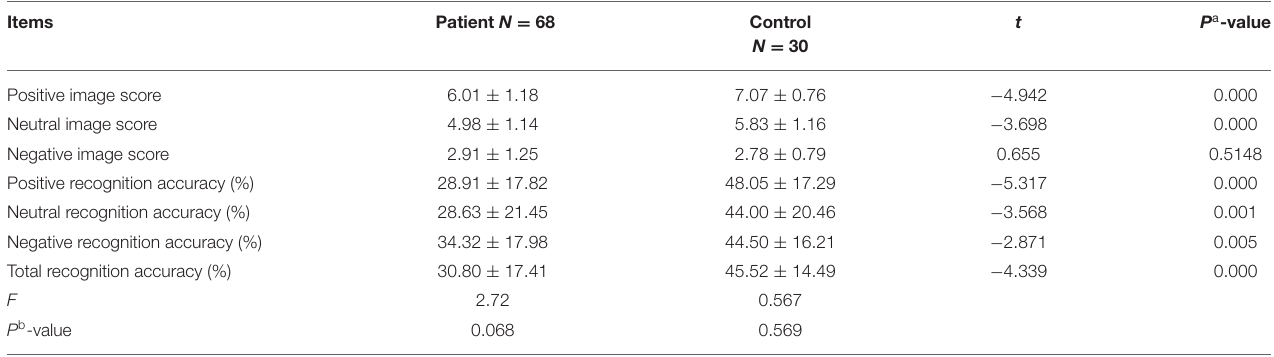
TABLE 2 | Comparative analysis of emotional memory between patient and control group ( X ± S ).